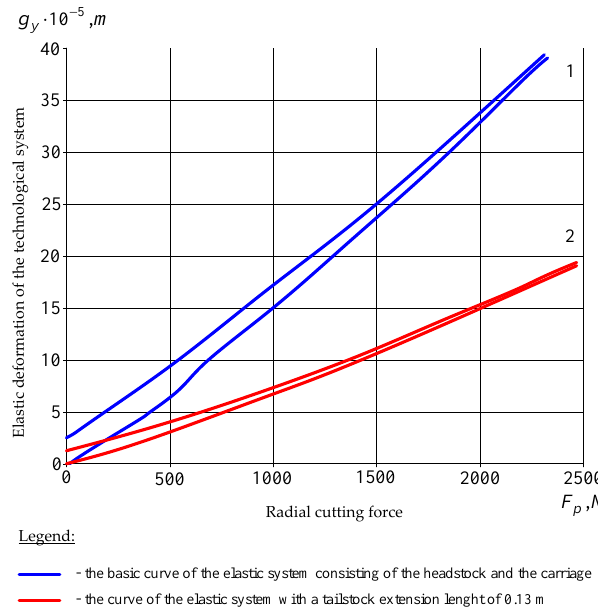
Figure 5. Static characteristics for the Y coordinate.